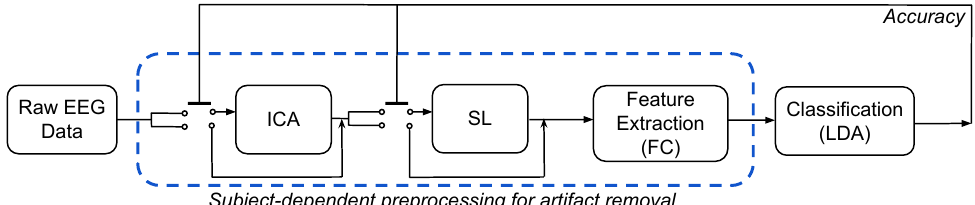
Figure 1. Diagram of the evaluated preprocessing approach to remove the effect of electrooculography and volume conduction. The dashed box highlights the proposed subject-dependent procedure for artifact removal ( SD-AR ) tested in subjects with poor MI